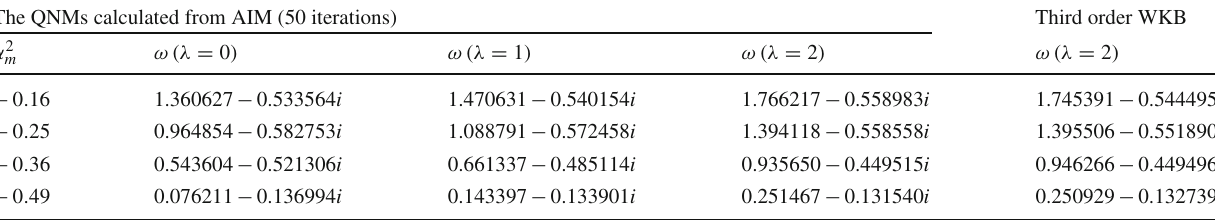
Table 3 The QNMs for massive scalar perturbations of a neutral black string for M = 1 ,α g = 1 ,(cid:14) = 0 ,γ = 1 . 9 , m s = 0 . 5 , k = 0 The QNMs calculated from AIM (50 iterations)